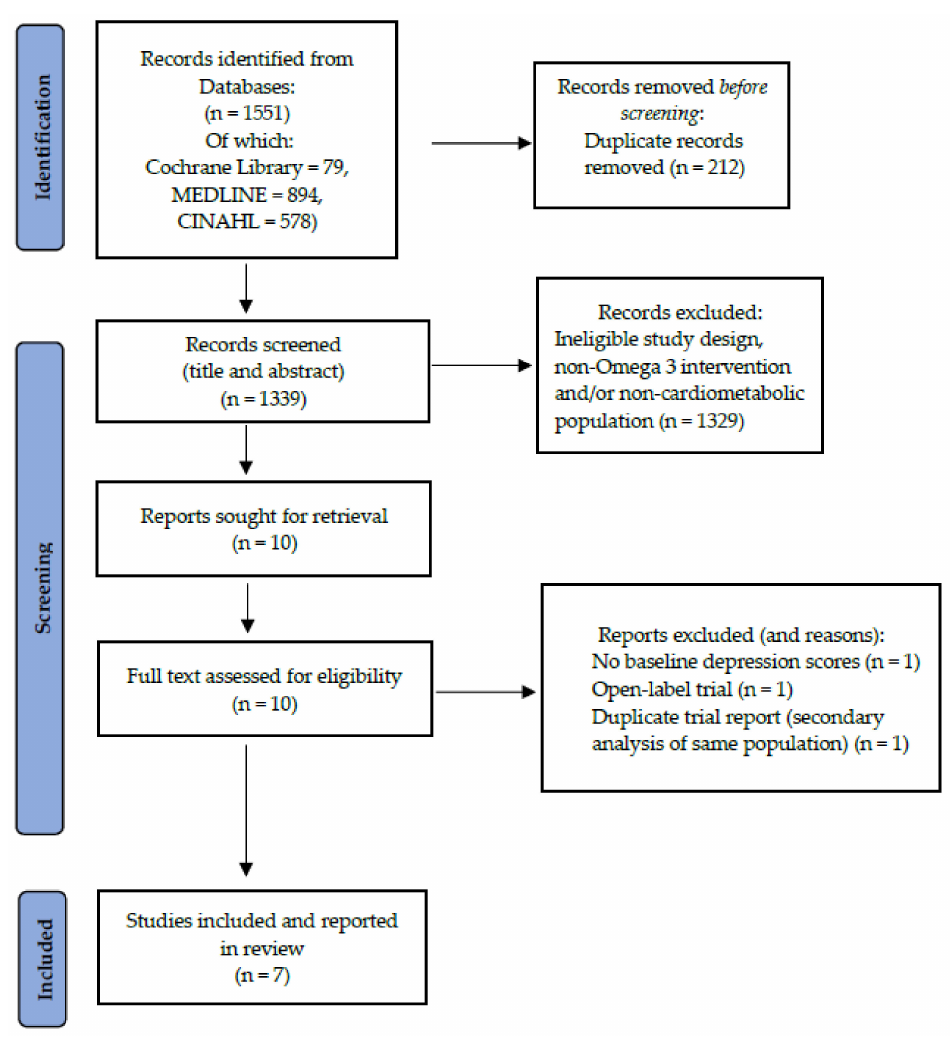
Figure 1. PRISMA flow